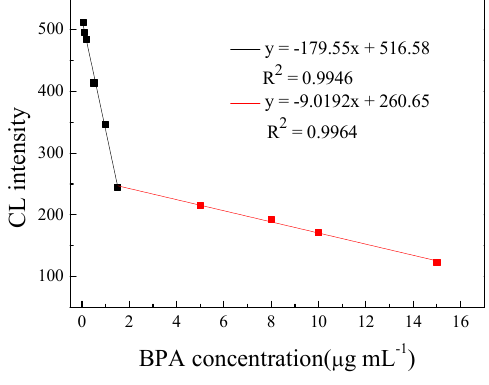
Figure 7. The linear response for different BPA concentration.